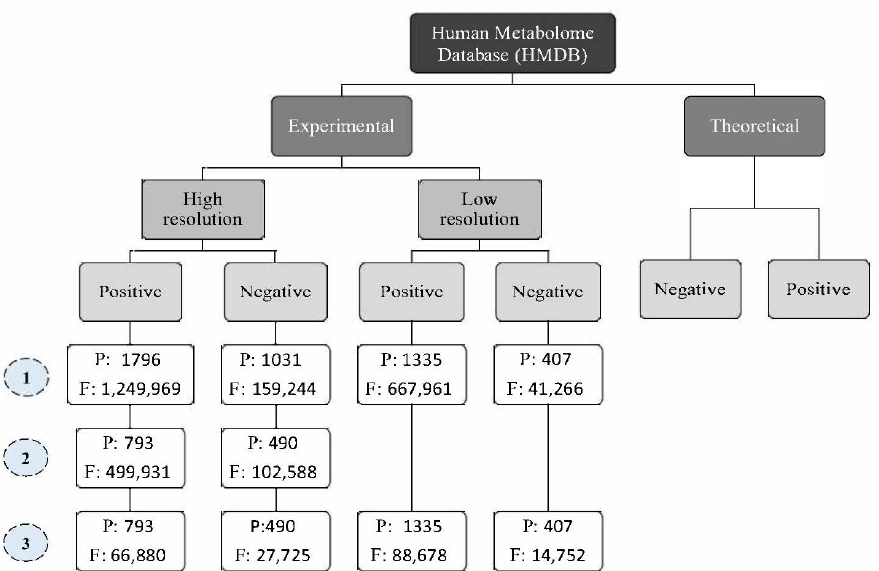
Figure 6. Human Metabolome Database (HMDB) classification. The sign No. (1) refers to the initially collected parents (P) and fragments (F). No. (2) shows the parents and fragments after removing the exogenous molecules. No. (3) represents the final parents and fragments data ‐ base.